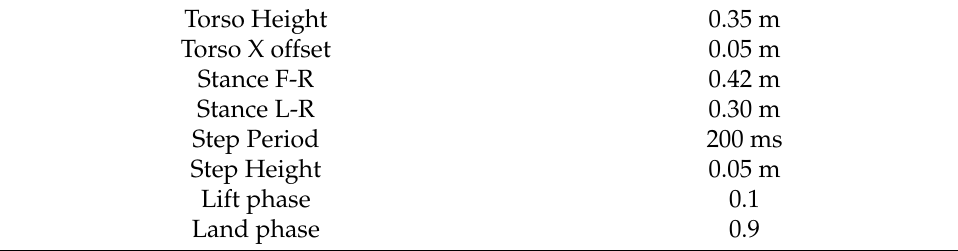
Table 4. Initial Walk